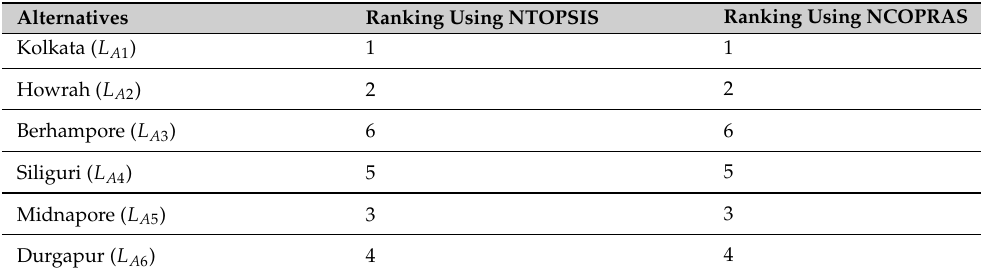
Figure 9. Depiction of alternatives ranking by removing Proximity of Educational institute ( ˜ m 9 ) . Table 22. Alternatives ranking by removing Proximity of Educational institute ( ˜ m 9 )